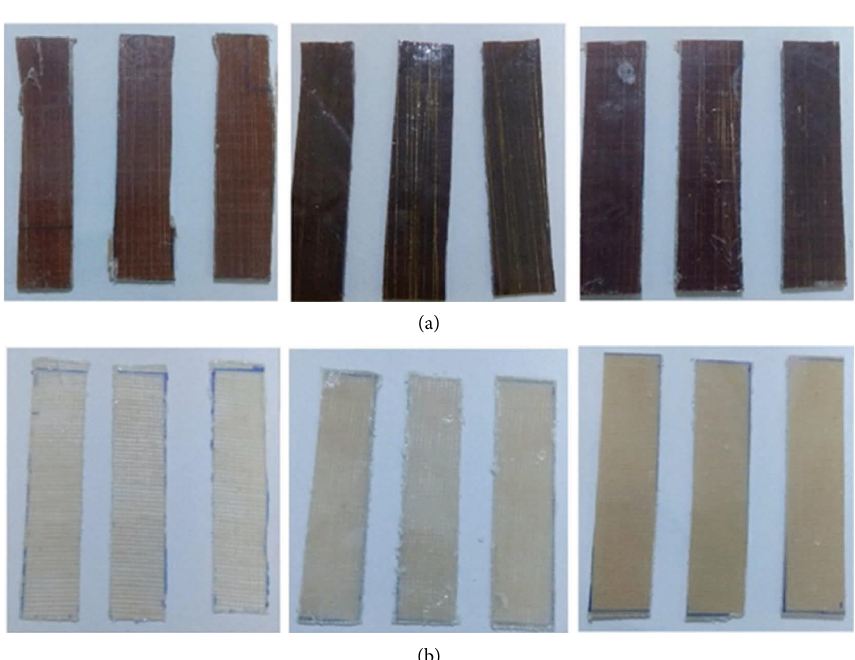
Figure 7: Composite samples prepared for tensile and fexural test characteristics estimation of: (a) single, double, and triple layers of silk fbres oriented in the biaxial manner; (b) single, double, and triple layers of reinforced silk cloth composite samples.